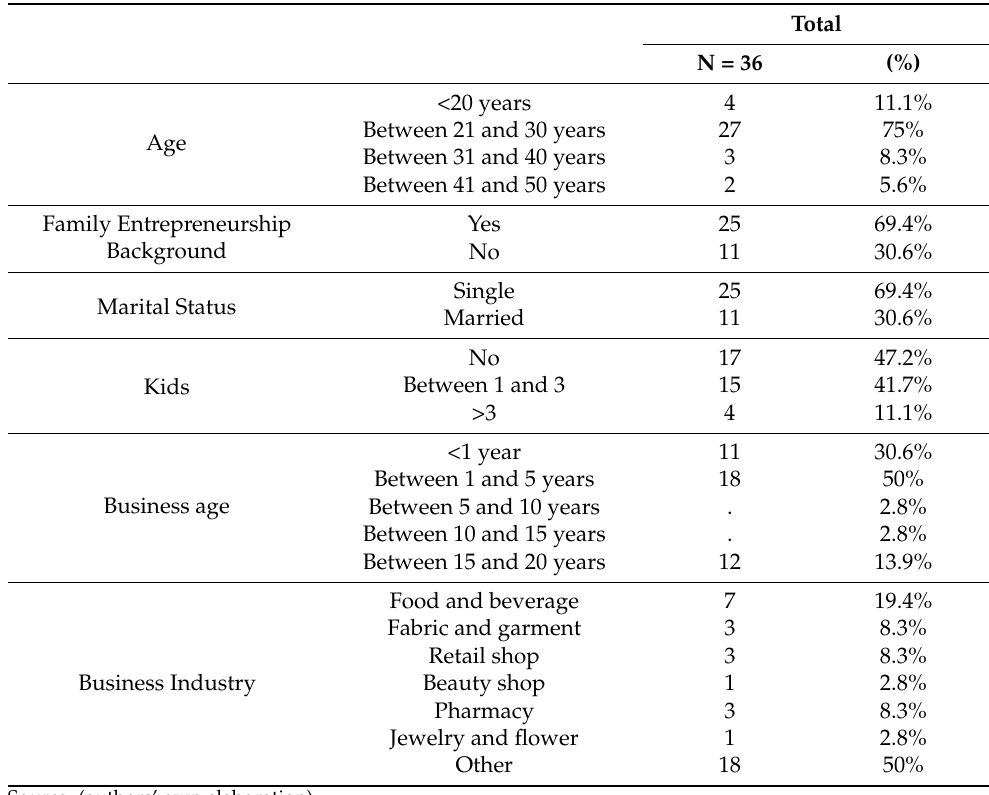
Table 1. General characteristics of the